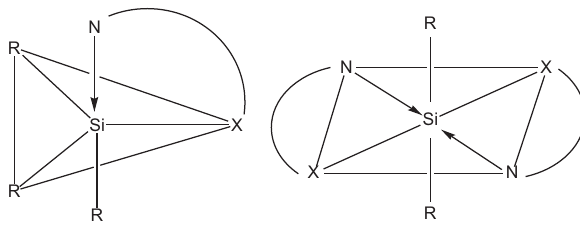
Figure 1 Structures of silicon(IV) complexes. X = O or S and R = Me or Ph. antimicrobial screening data indicate that the silicon complexes are more potent antimicrobial agents than the free ligands.